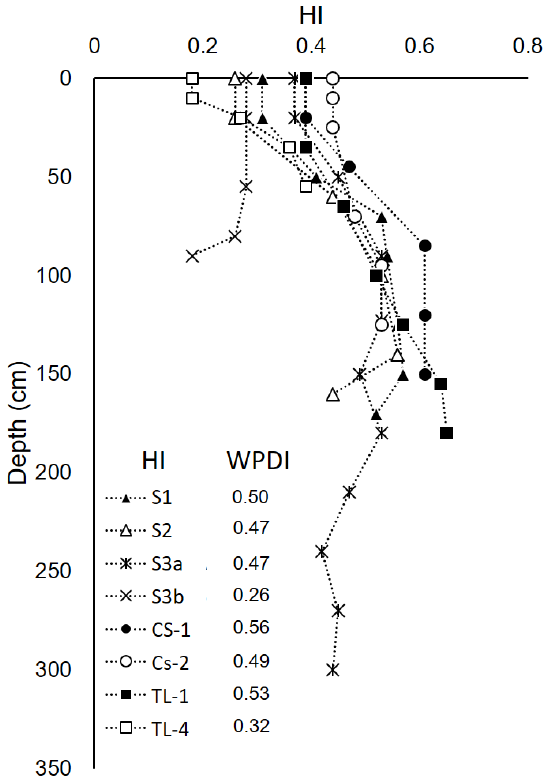
Figure 6. HI with depths and WPDI of the soils. HI and WPDI values of CS-1, CS-2, TL-1, and TL-4 were calculated by Tsai et al. [23].